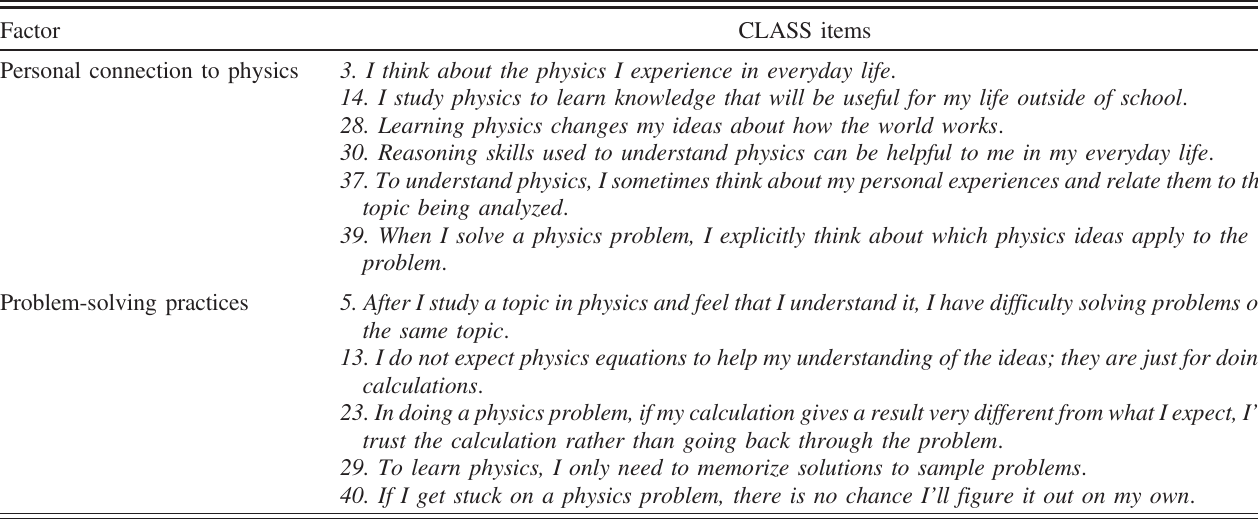
TABLE XI. CLASS items in 11-item, two-factor model, sorted by factor.